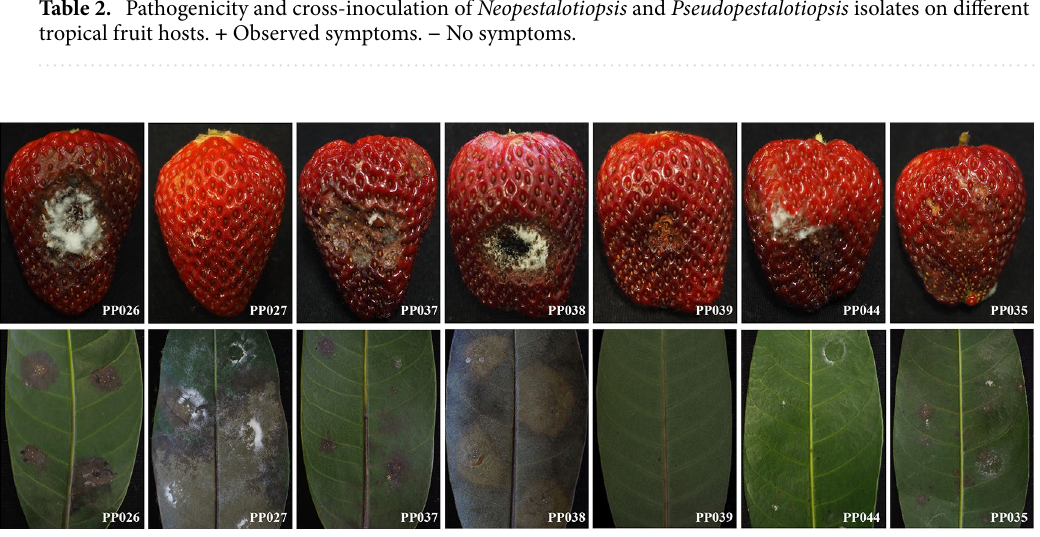
Figure 5. Pathogenicity of Neopestalotiopsis (PP026, PP027, PP037, PP038, PP039, and PP044) and Pseudopestalotiopsis (PP035) isolates on ( a ) strawberry fruits and ( b ) plum